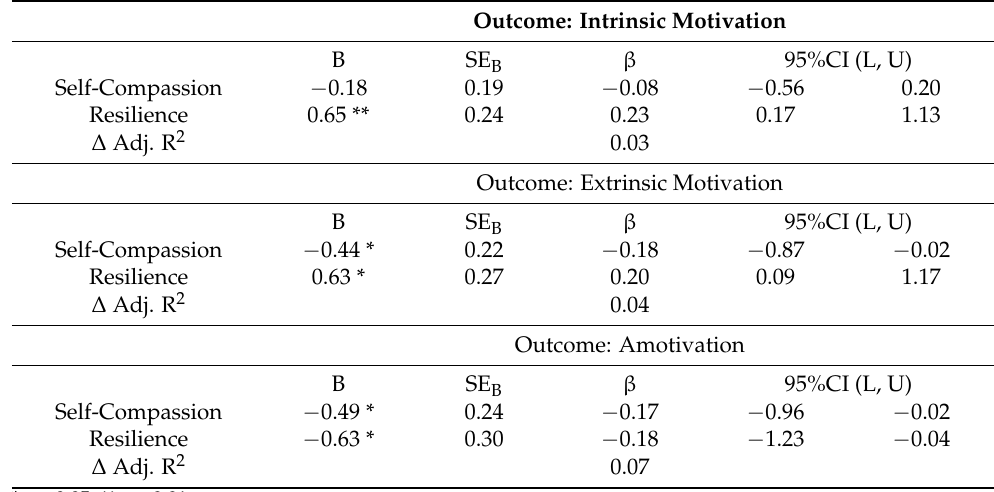
Table 2. Multiple regression: Self-compassion and resilience for each type of academic motivation (intrinsic motivation, extrinsic motivation and amotivation) in 156 Indonesian